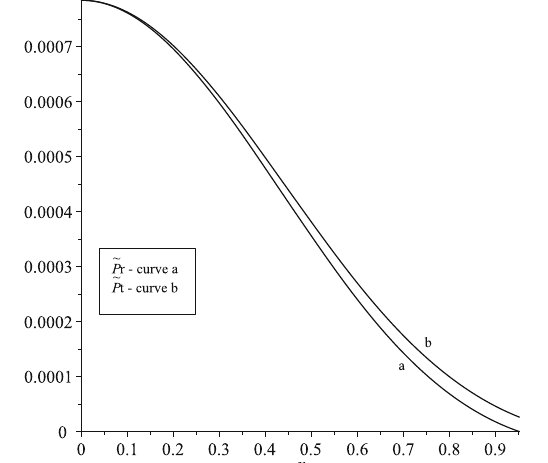
Fig. 21 Gradients pressures for the solution obtained with the second algorithm with ˜ F (cid:9)= 0 form the isotropic Gold III solution